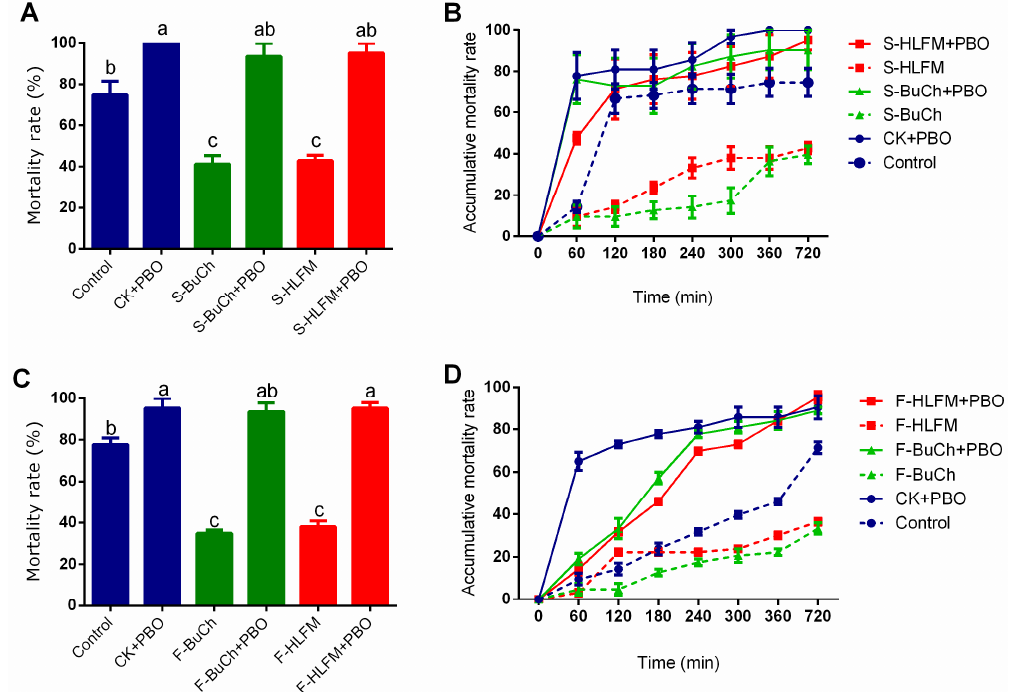
Figure 1. Effects of volatile smelling and diet feeding of herbicides on mortality of H. armigera caterpillars treated with methomyl. Mortality rates ( A ) and Accumulative mortality rates ( B ) of H. armigera caterpillars treated with methomyl after pre-exposed of volatile herbicides. Mortality